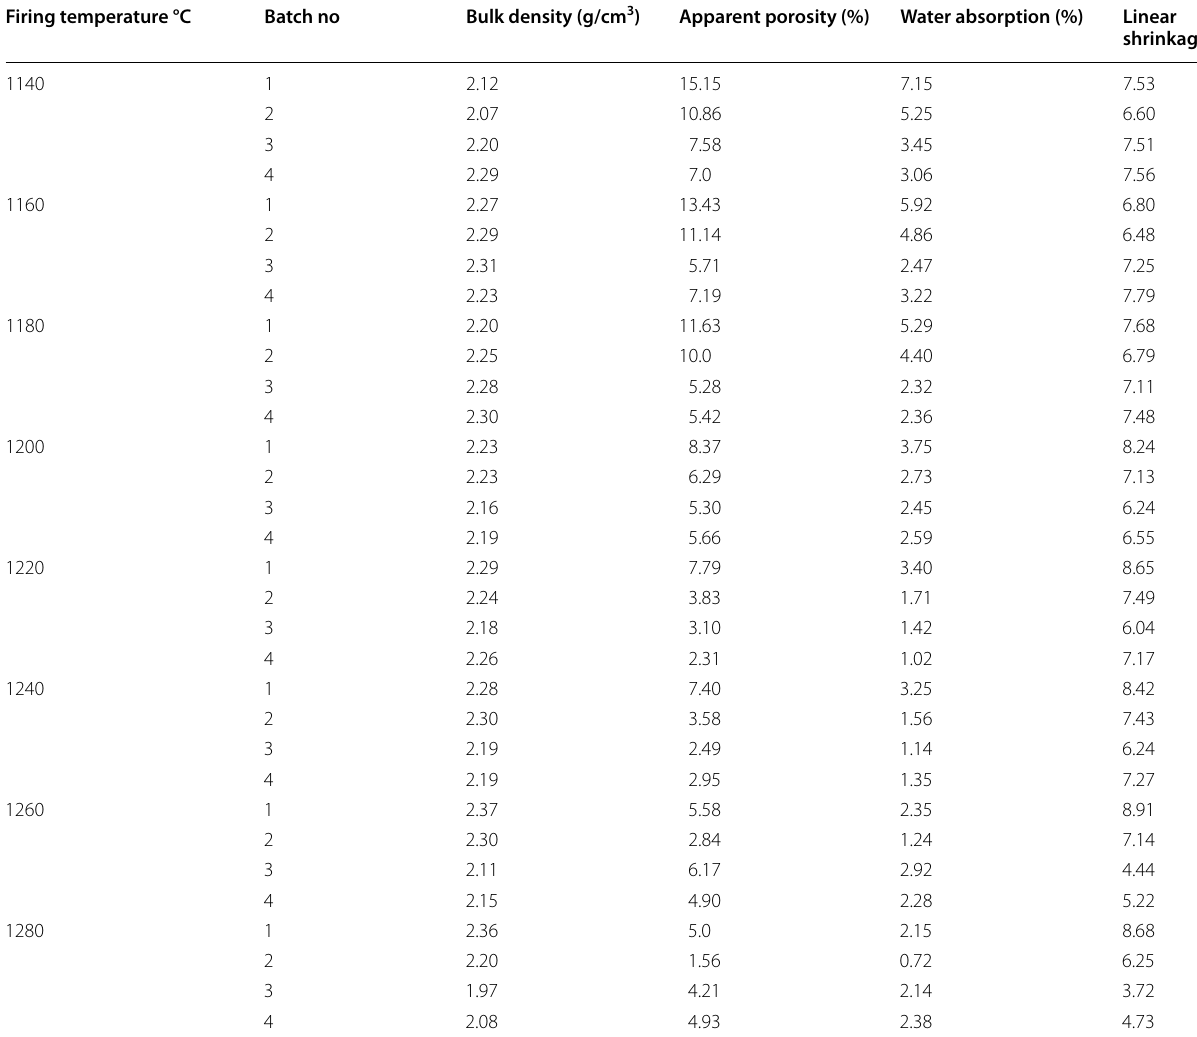
Table 7 Densification parameters of the fired batches Firing temperature °C Batch no Bulk density (g/cm 3 ) Apparent porosity (%) Water absorption